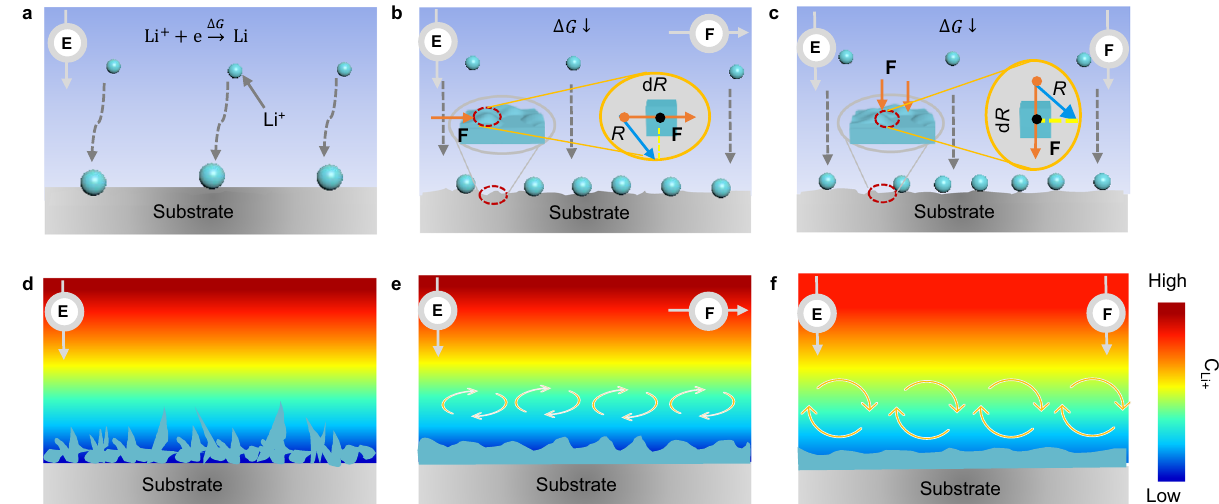
Fig. 3 Morphological evolution of the Li metal depositions. Schematic illustrations of the nucleation and growth of Li metal under a , d 1G gravity, b , e perpendicular and c, f parallel supergravity conditions. Note that “ E ” represents the applied electric fi eld, “ F ” represents the applied supergravity, and the color change represents the difference in ion concentration in the